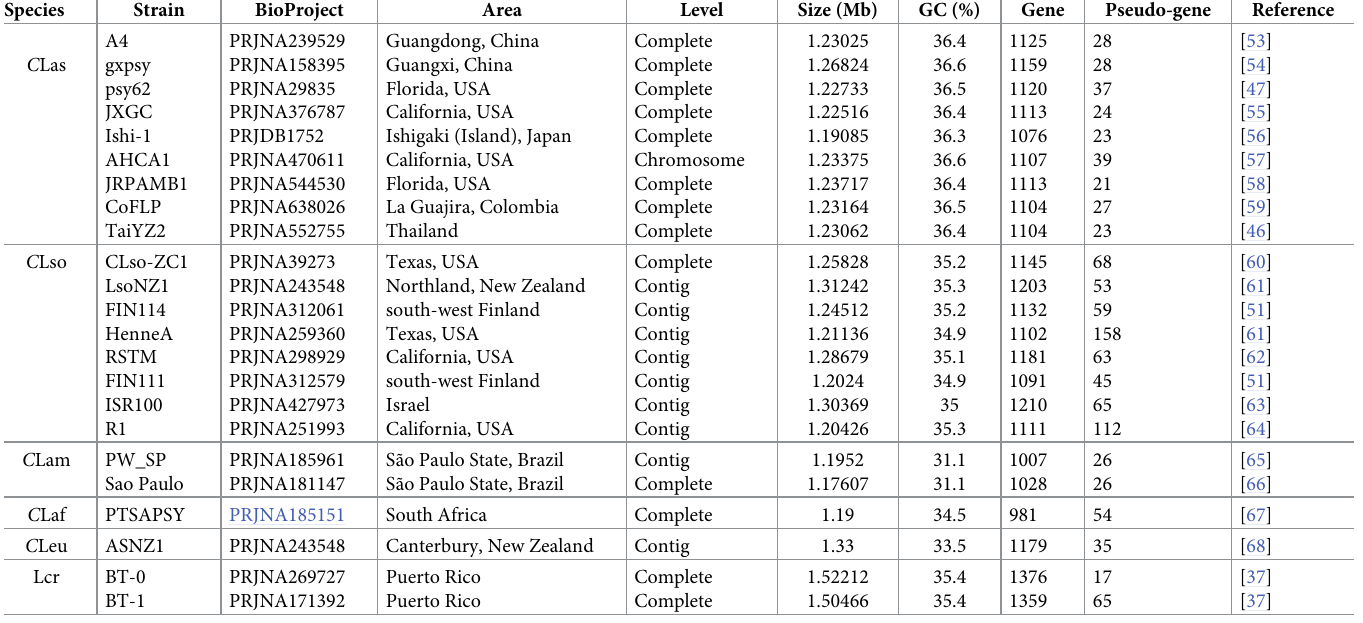
Table 1. The genomic features of sequenced Ca . Liberibacter species.